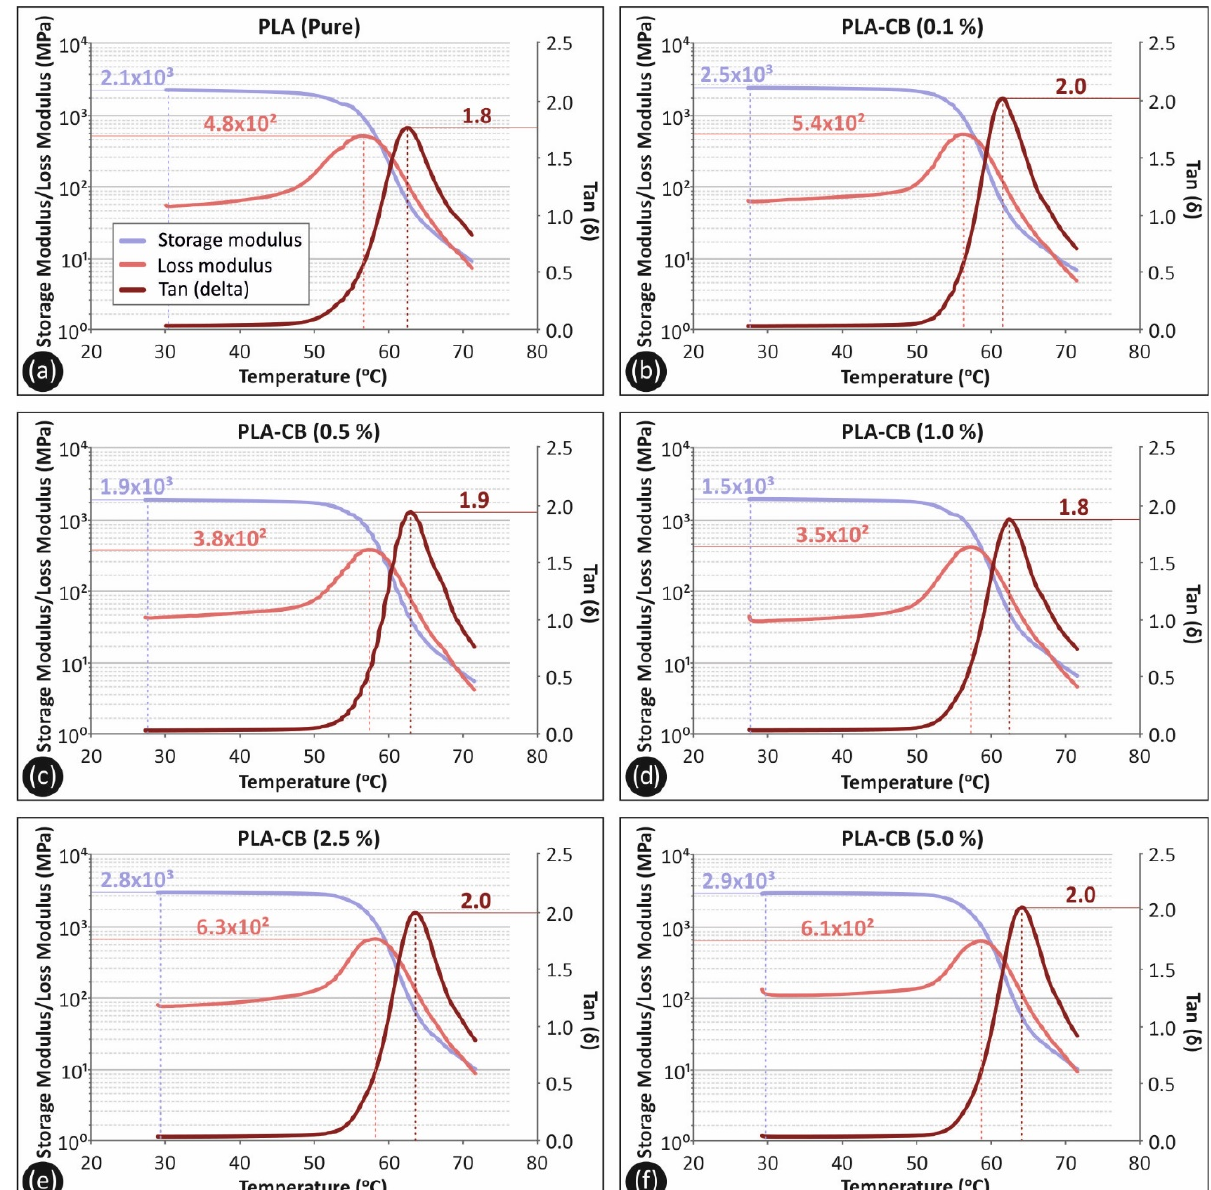
Figure 11. Storage modulus, loss modulus and Tan δ plots of the neat PLA and PLA/CB nanocomposites at different filler loadings: ( a ) pure PLA, ( b ) PLA/CB wt.% 0.1, ( c ) PLA/CB wt.% 0.5, ( d ) PLA/CB wt.% 1.0, ( e ) PLA/CB wt.% 2.5, ( f ) PLA/CB wt.% 5.0.